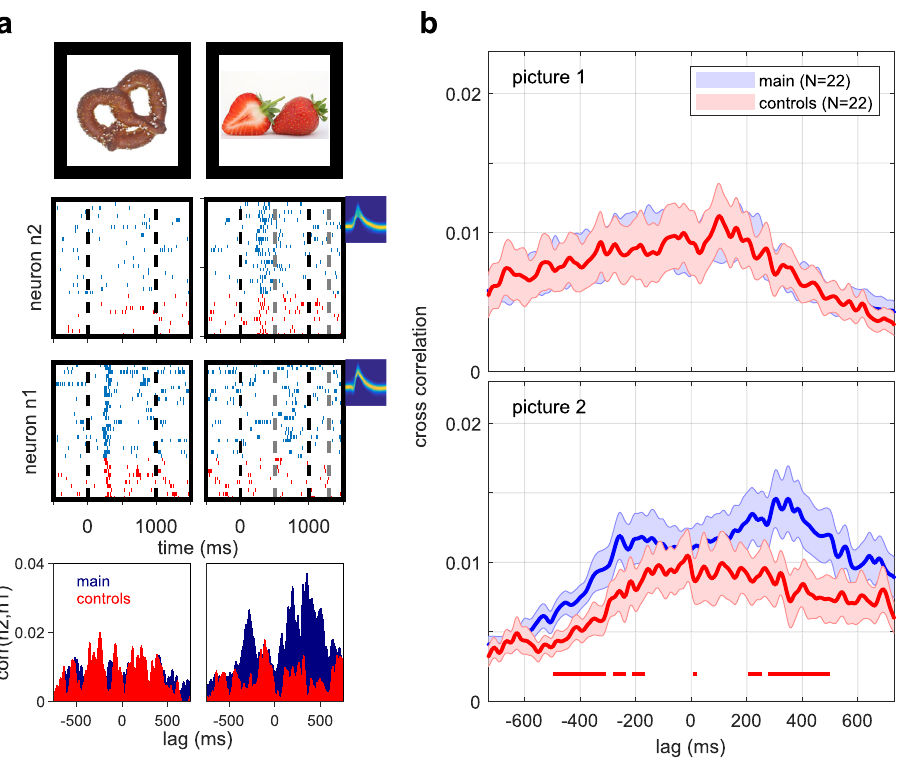
Fig. 3 Firing sequences of local pairs of concept neurons re fl ect concept relations, potentially leading to synapse modi fi cation. a Raster plots, normalized cross-correlograms and spike shapes of two concept neurons in the right hippocampus during the presentation of each neuron ’ s preferred stimulus (pretzel for n1 and strawberry for n2). In the main condition (blue), but not during controls (red) neuron n1 responded to the non-preferred strawberry picture (relational response on lower right). Bottom: Trial-by-trial cross-correlograms between both neurons during each picture presentation with colors as above. Peaks around − 250, and + 350 ms were present only for second picture presentations in the main condition. b Population plots of trial-by-trial cross-correlograms between all pairs of concept neurons of the same brain region. Data are presented as mean values ± SEM (solid lines and shaded areas). Red horizontal lines indicate signi fi cant differences ( p < 0.01) between the main-comparison condition and controls as quanti fi ed by a two- sided cluster permutation test. Pictures of objects ( a ) were obtained from https://commons.wikimedia.org under the Creative Commons CC0 1.0 Universal Public Domain Dedication. Source data are provided as a Source Data fi